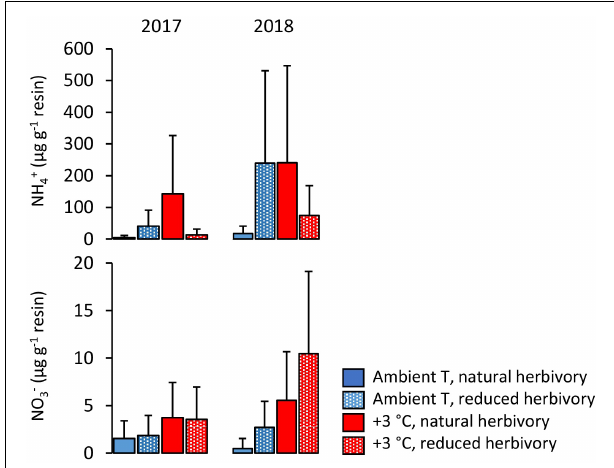
FIGURE 4 | NH 4 + and NO 3 − contents of resin bags incubated for one (2017) or two (2018) full growing seasons under Subarctic field layer vegetation growing in ambient or +3 ◦ C temperature and with either natural or reduced insect herbivory. The means and errors are estimated marginal means and SE values ( n = 5) produced by the fitted statistical models and were back-transformed from log-transformed data.